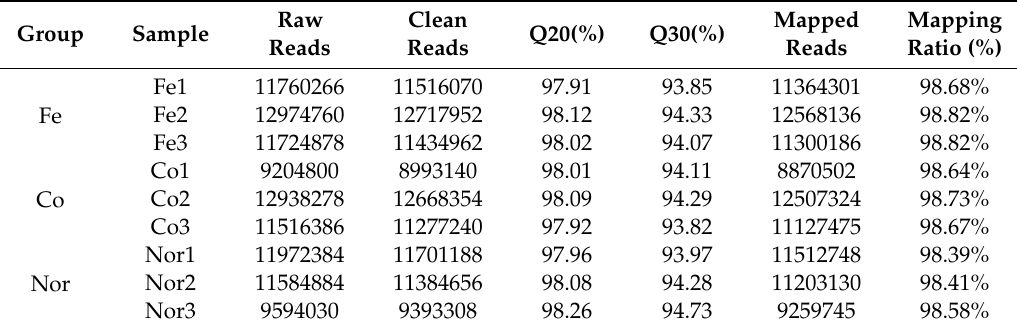
Table 2. Summary of RNA Sequencing